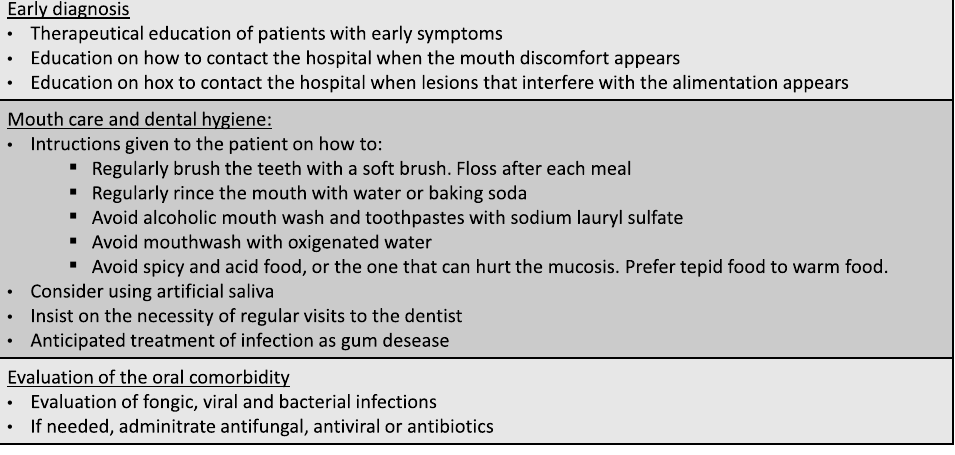
Fig. 5. Suggested strategies to prevent or manage mTOR-inhibitor-associated stomatitis [10].